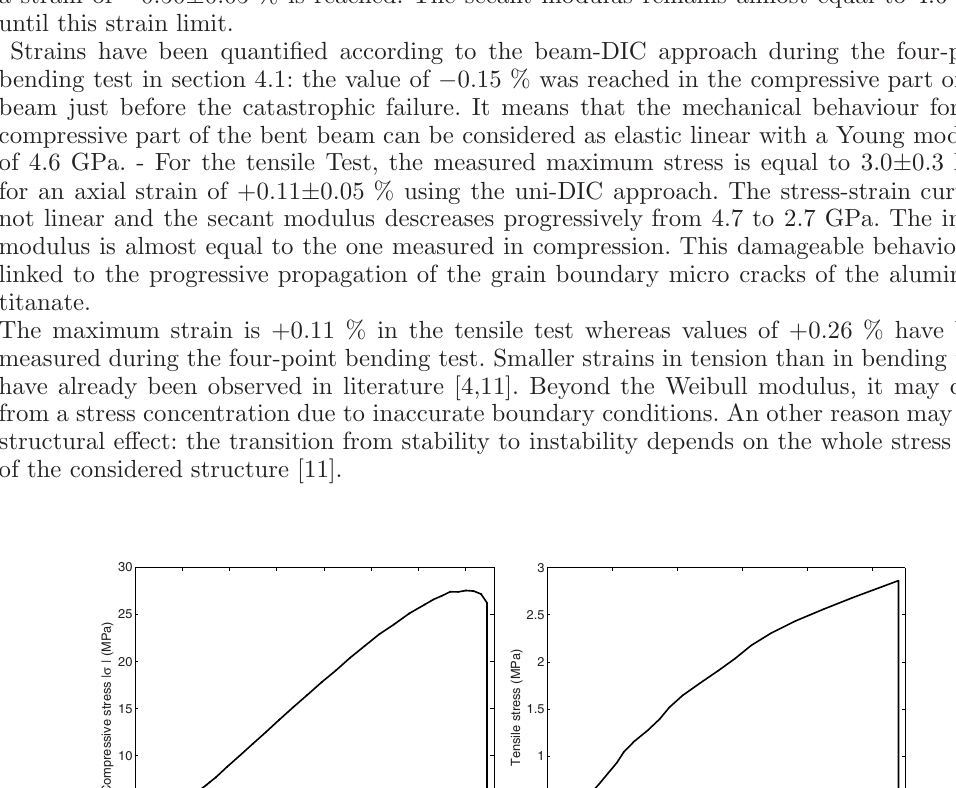
Figure 5. Stress-Strain results obtained using the uni-DIC approach for the compressive (left) and tensile (right) tests on aluminium titanate